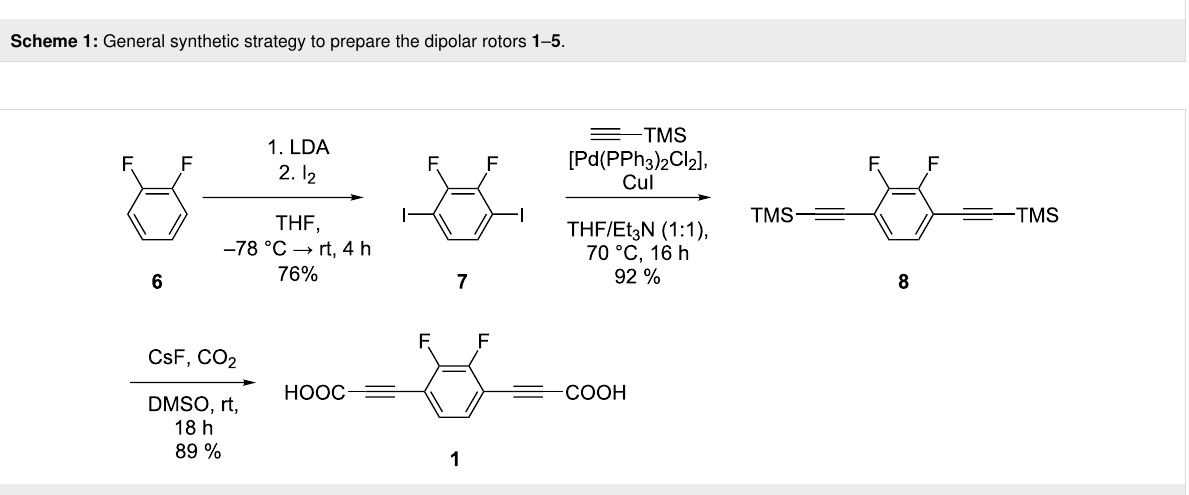
Scheme 2: Synthesis of 3,3'-(2,3-difluoro-1,4-phenylene)dipropiolic acid ( 1 ) starting with diiodination of 1,2-difluorobenzene ( 6 ), followed by Sono- gashira reaction with trimethylsilylacetylene and subsequent direct conversion to the dicarboxylic acid.